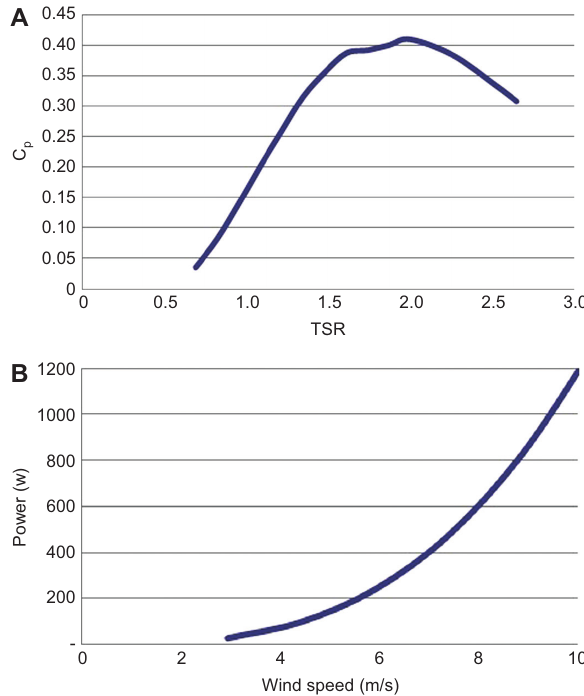
Figure 7 Stream line distribution for fluid flow analysis using ANSYS. Table 2 Definition of load cases considered in structural